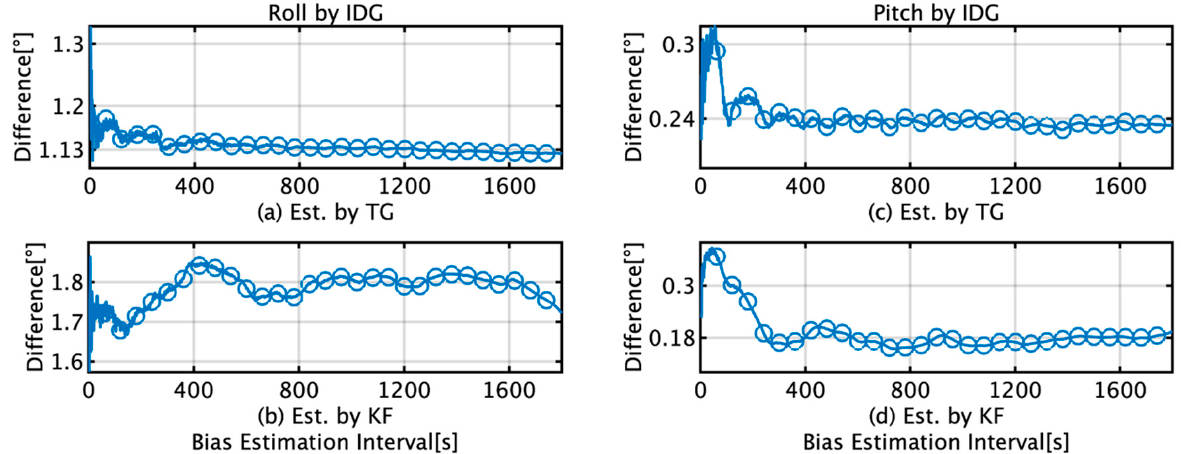
Figure 12. RMS difference between estimates by the IDG and FOG during a 1 h voyage and the initial bias estimates from the TG and KF. ( a ) Roll difference when initial bias is estimated by TG; ( b ) Roll